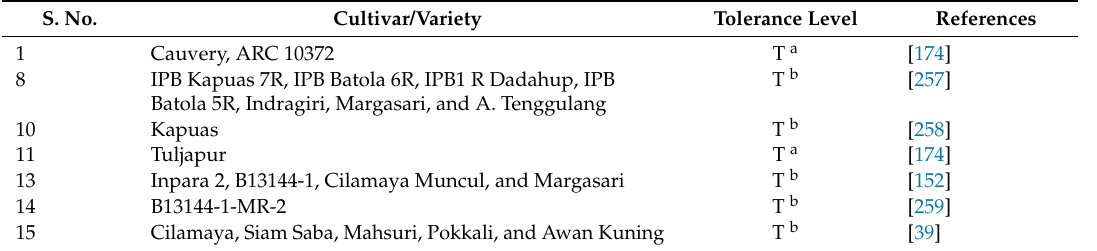
Table 4. List of genotypes identified for FT- and FD-tolerant rice cultivars. S.